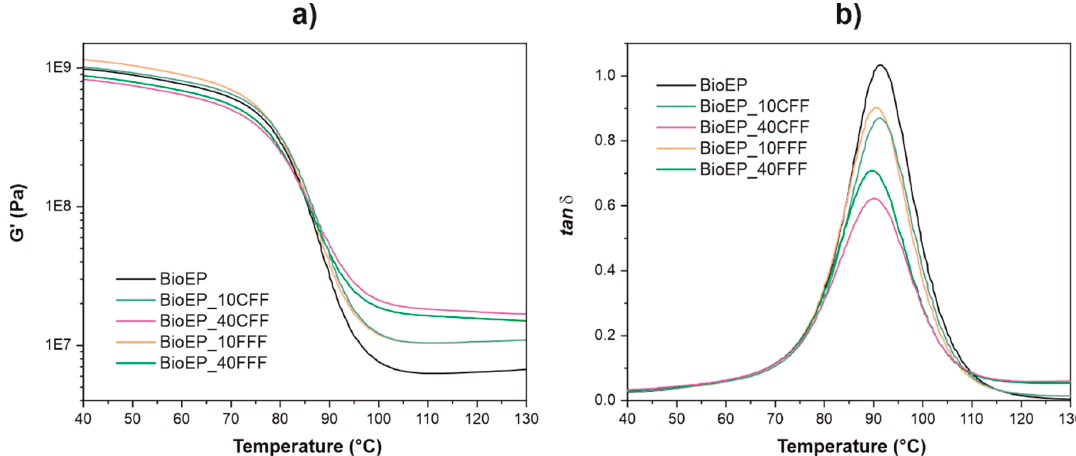
Figure 6. A comparative plot of the dynamic mechanical thermal analysis (DMTA) behavior of BioEP and BioEP / FF composites reinforced with CFF (10 and 40 wt%) and FFF (10 and 40 wt%): ( a ) storage modulus ( G’ ), and ( b ) dynamic damping factor ( tan δ ).